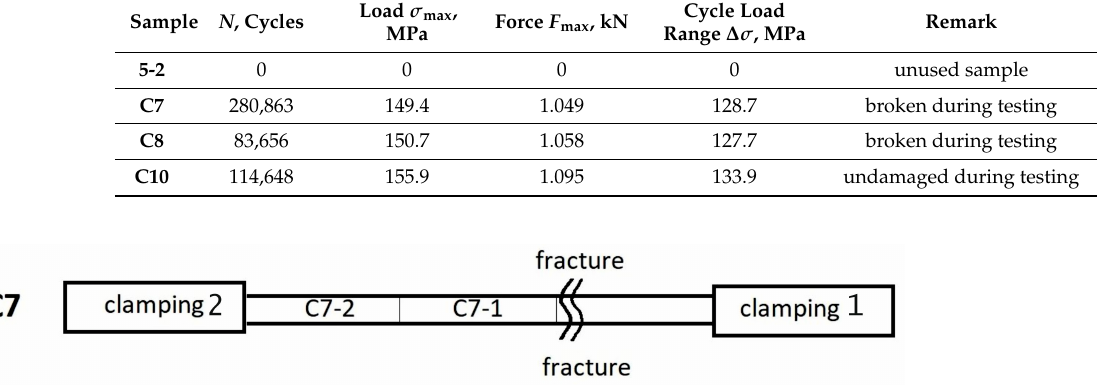
Table 1. Cyclic fatigue test conditions for Al wires of A50 cables.